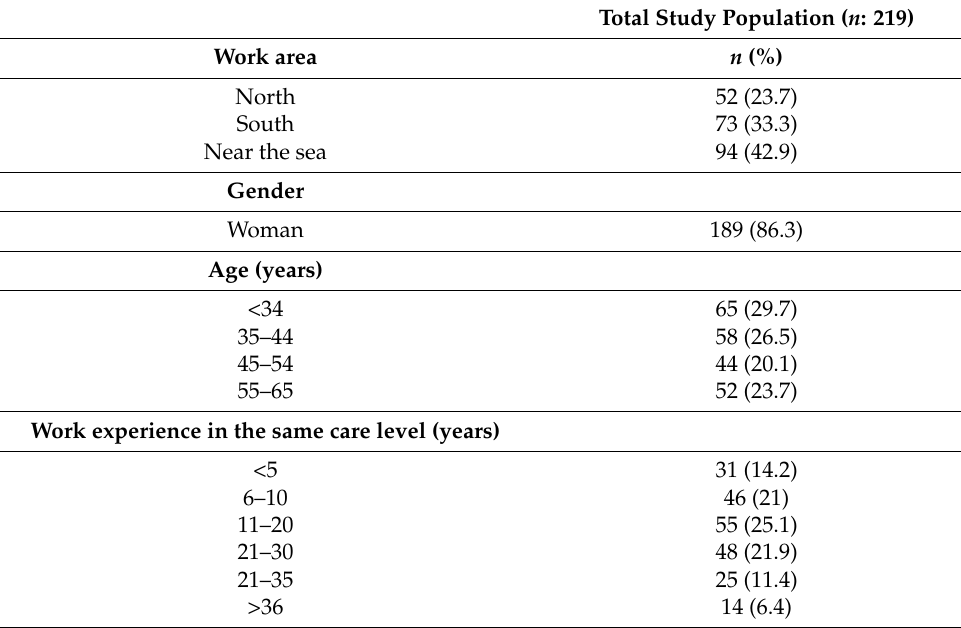
Table 1. Socio-demographic and employment characteristics of the